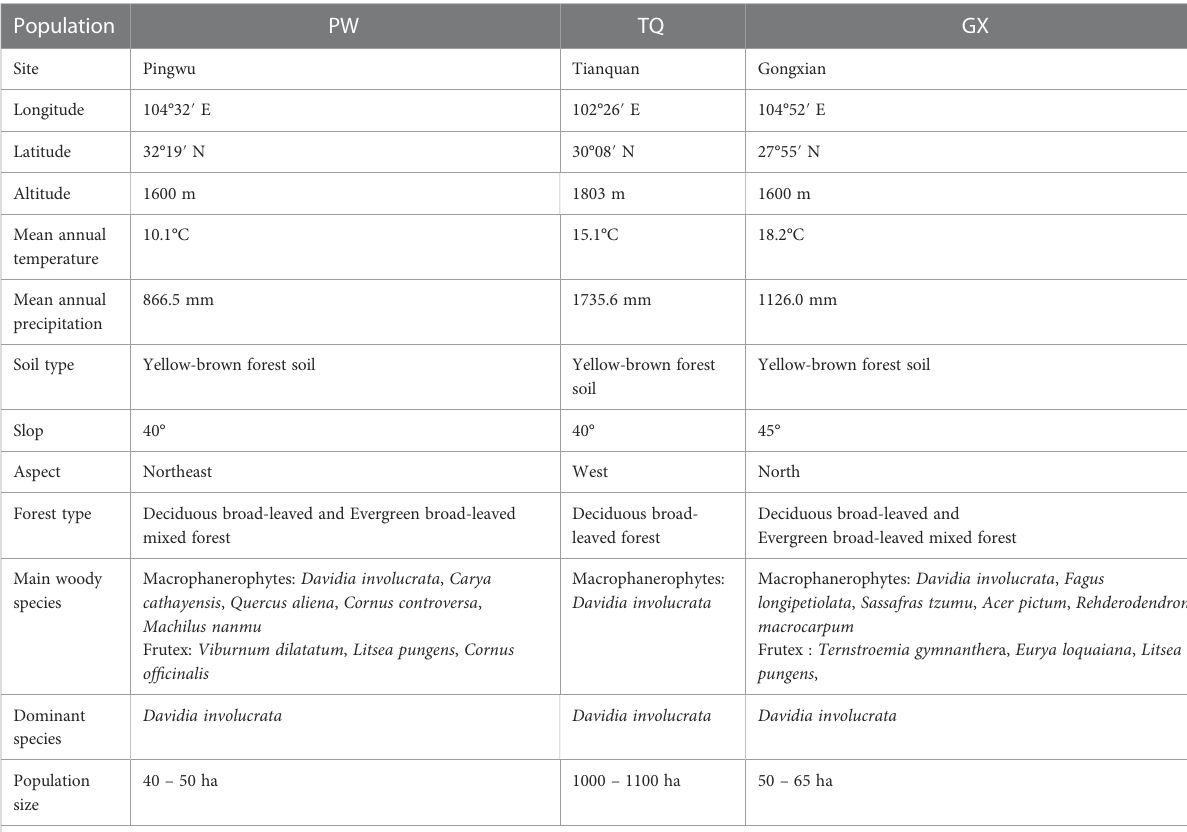
TABLE 1 The general information of D . involucrata populations in three latitude